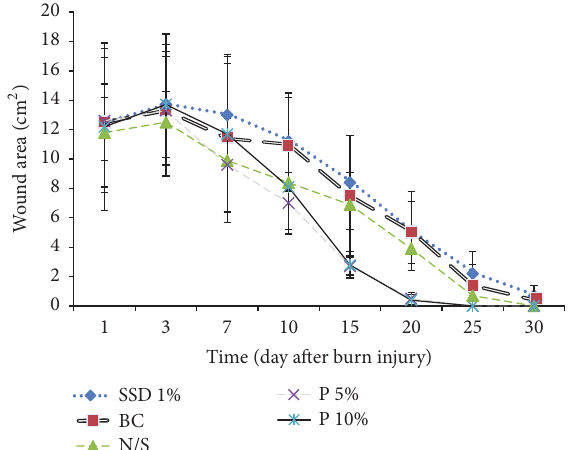
Figure 2: Mean wound area (cm 2 ) of the animal groups treated with various topical creams. Silver sulfadiazine 1% (SSD 1%), normal saline (N/S), base cream (BC), Punica granatum flowers cream 5% (P 5%), and Punica granatum flowers cream 10% (P 10%). P 5% with SSD 1% ( 𝑃 < 0.003 ) and P 10% with SSD 1% ( 𝑃 < 0.004